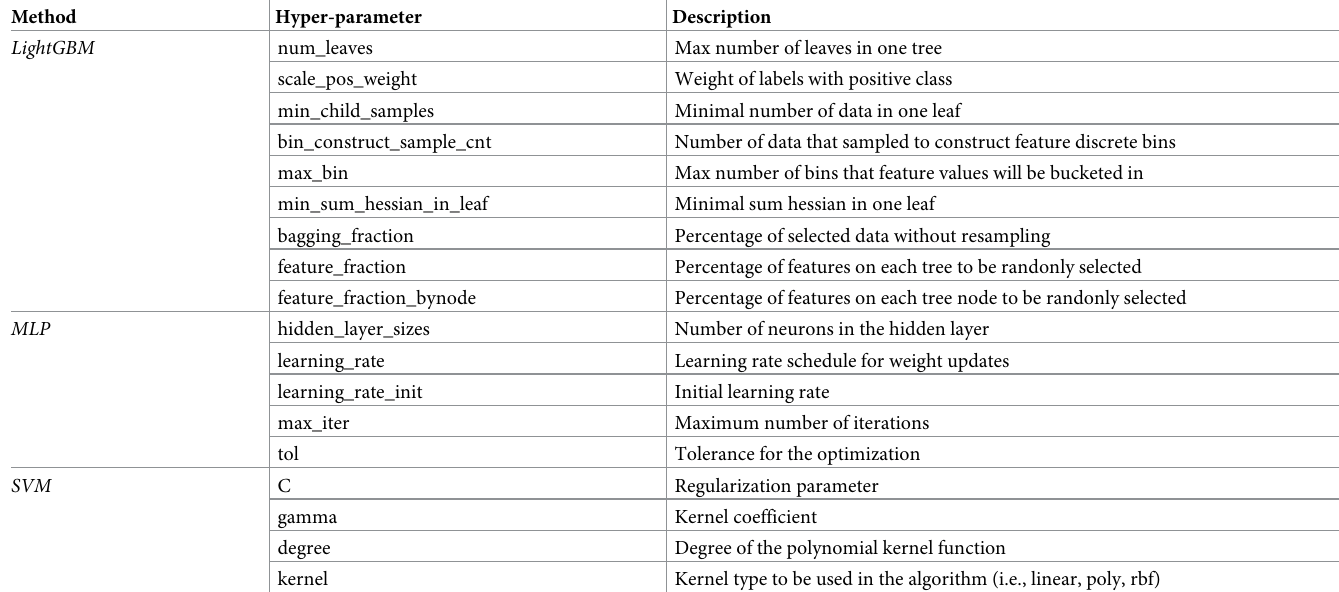
Table 3. List of optimized hyper-parameters per ML